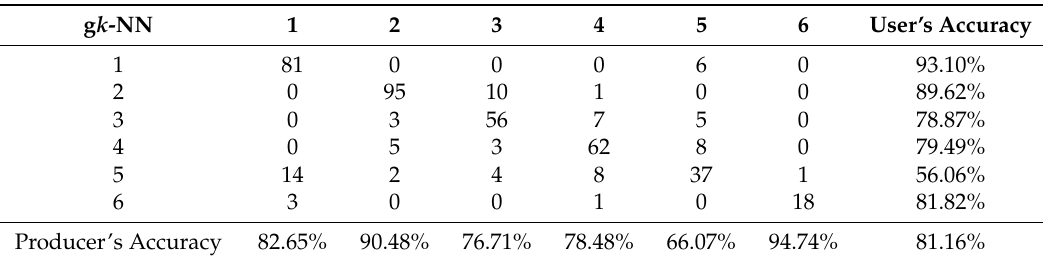
Table 5. Error matrix using the g k -NN method (Class name: 1, bamboo; 2, coniferous; 3, broadleaved; 4, mixed woodland; 5, brush; 6, barren land), Kappa =